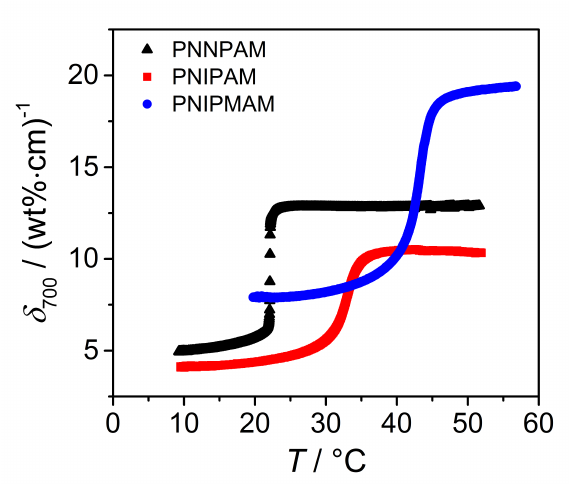
Figure 9. Normalized light attenuation δ 700 at λ = 700nm for PNNPAM ( black curve ), PNIPAM ( red curve ) and PNIPMAM microgels ( blue curve ) as a function of temperature measured by UV/Vis